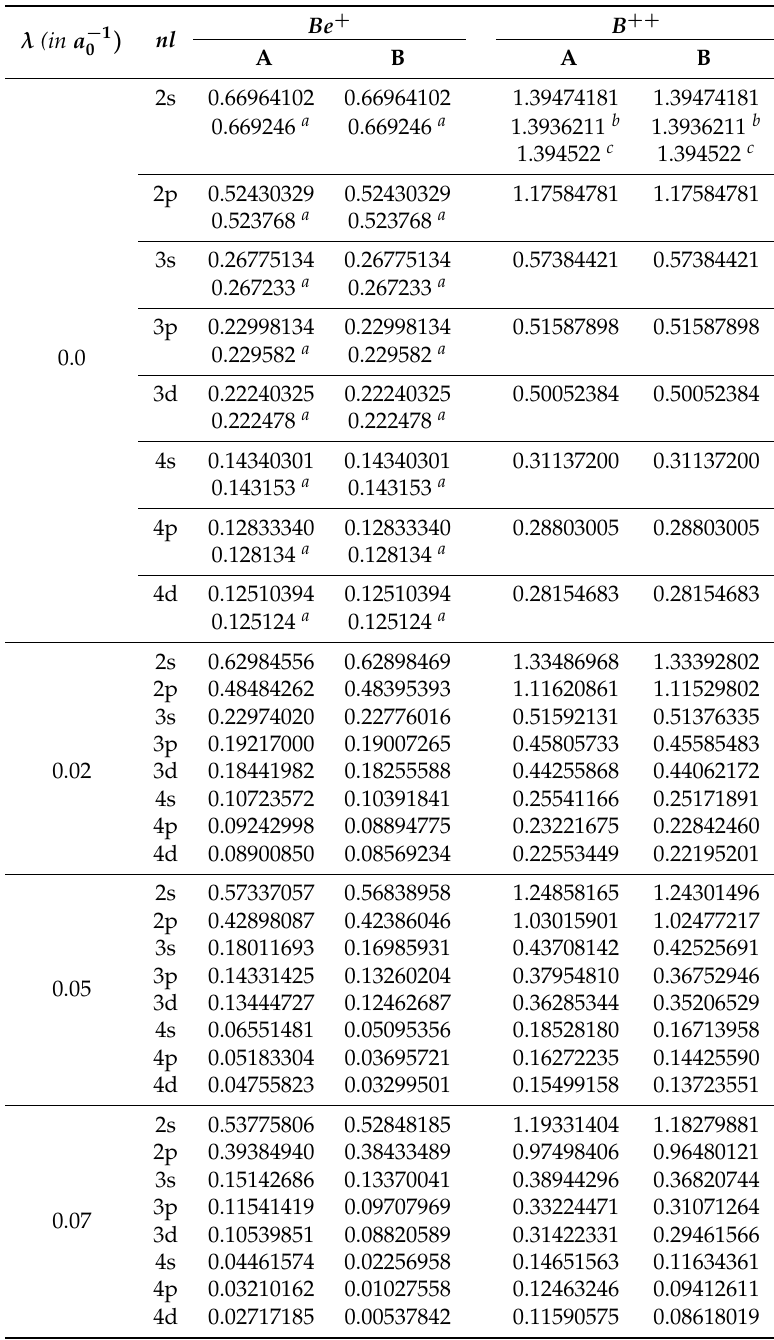
Table 1. Energies (-E a.u.) of the 1 s 2 nl states of Be + and B ++ ions in static screened Coulomb potential (SSCP) and exponential cosine screened Coulomb potential (ECSCP) determined by using the wave function (9). All values refer to the respective core energies. A and B respectively stand for SSCP and ECSCP. Numbers with superscripts ‘ a ’, ‘ b ’ and ‘ c ’ denote the corresponding results of Reference [49] (experimental observation) and Reference [50,51] respectively.